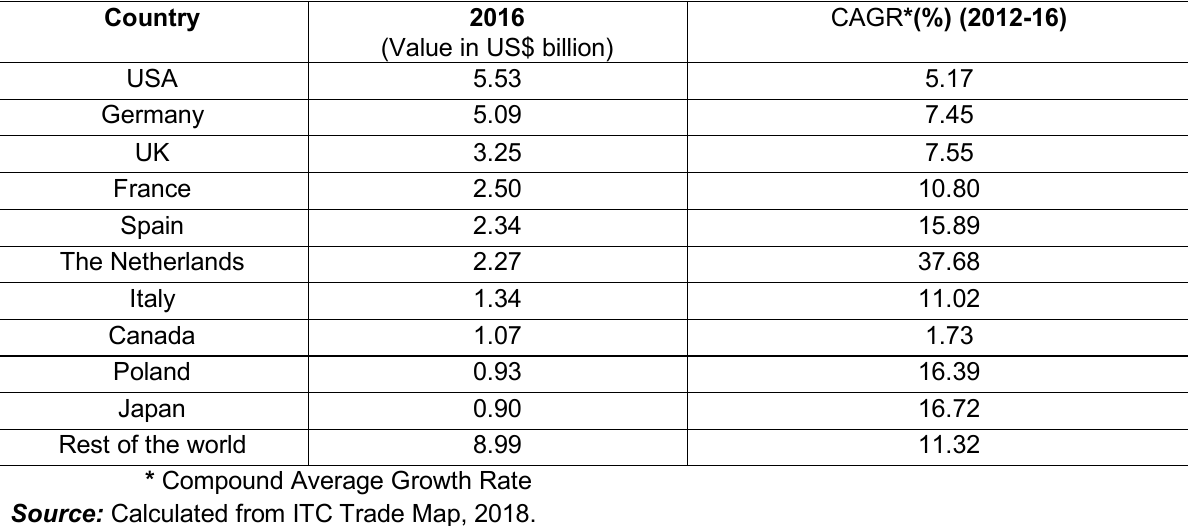
Table 1. Major Export Market of Bangladesh RMG Sector Country